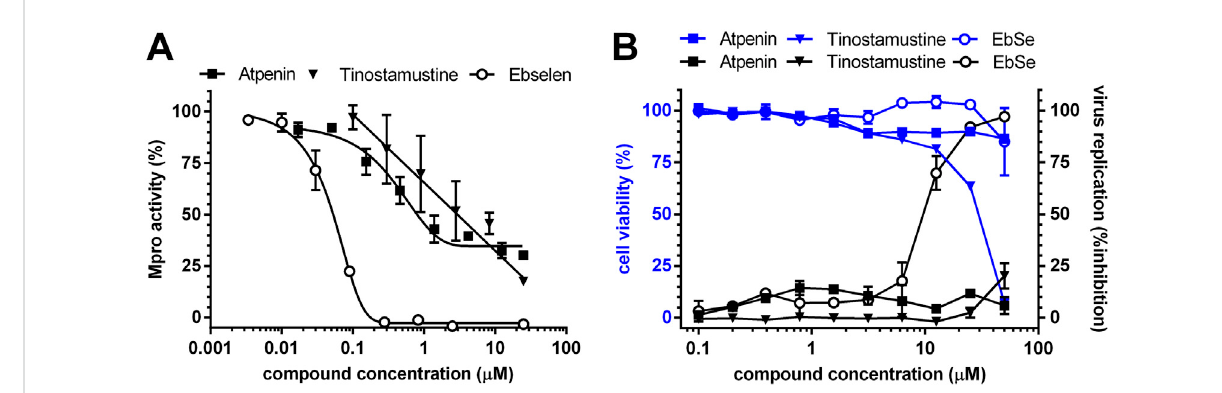
FIGURE 3 Drug testing against MPro and SARS-CoV-2. (A) Concentration-response plots for MPro inhibitors. The data were fi tted to non-linear (sigmoidal,foratpeninandebselen)orlinear(tinostamustine)equations. (B) Concentration-responseplotsforanti-viralandcytotoxicactivityagainst SARS-CoV-2 Vero-infected cells. Viral replication and cell viability were quanti fi ed by measuring levels of SARS-CoV-2 nucleocapsid protein and host nuclear DNA by fl uorescence microscopy. For further details see Section 2.4.1 and Section